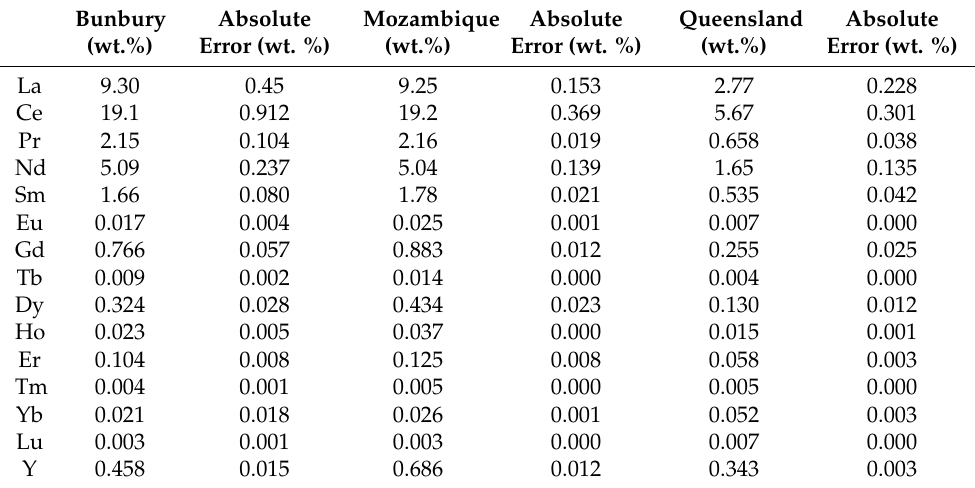
Table 5. Elemental composition: Assay of various monazites, 3 g